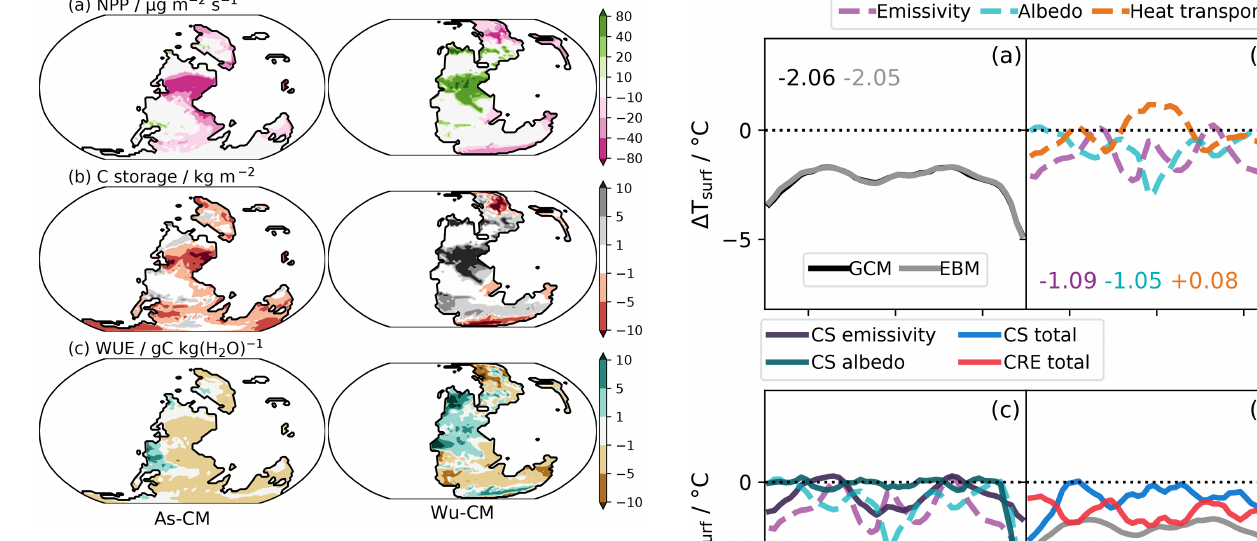
(left) and Wu-CM 35 (right) anomalies for (a) Figure 14. As-CM 35 10 10 net primary productivity, (b) total carbon storage and (c) water use efficiency.